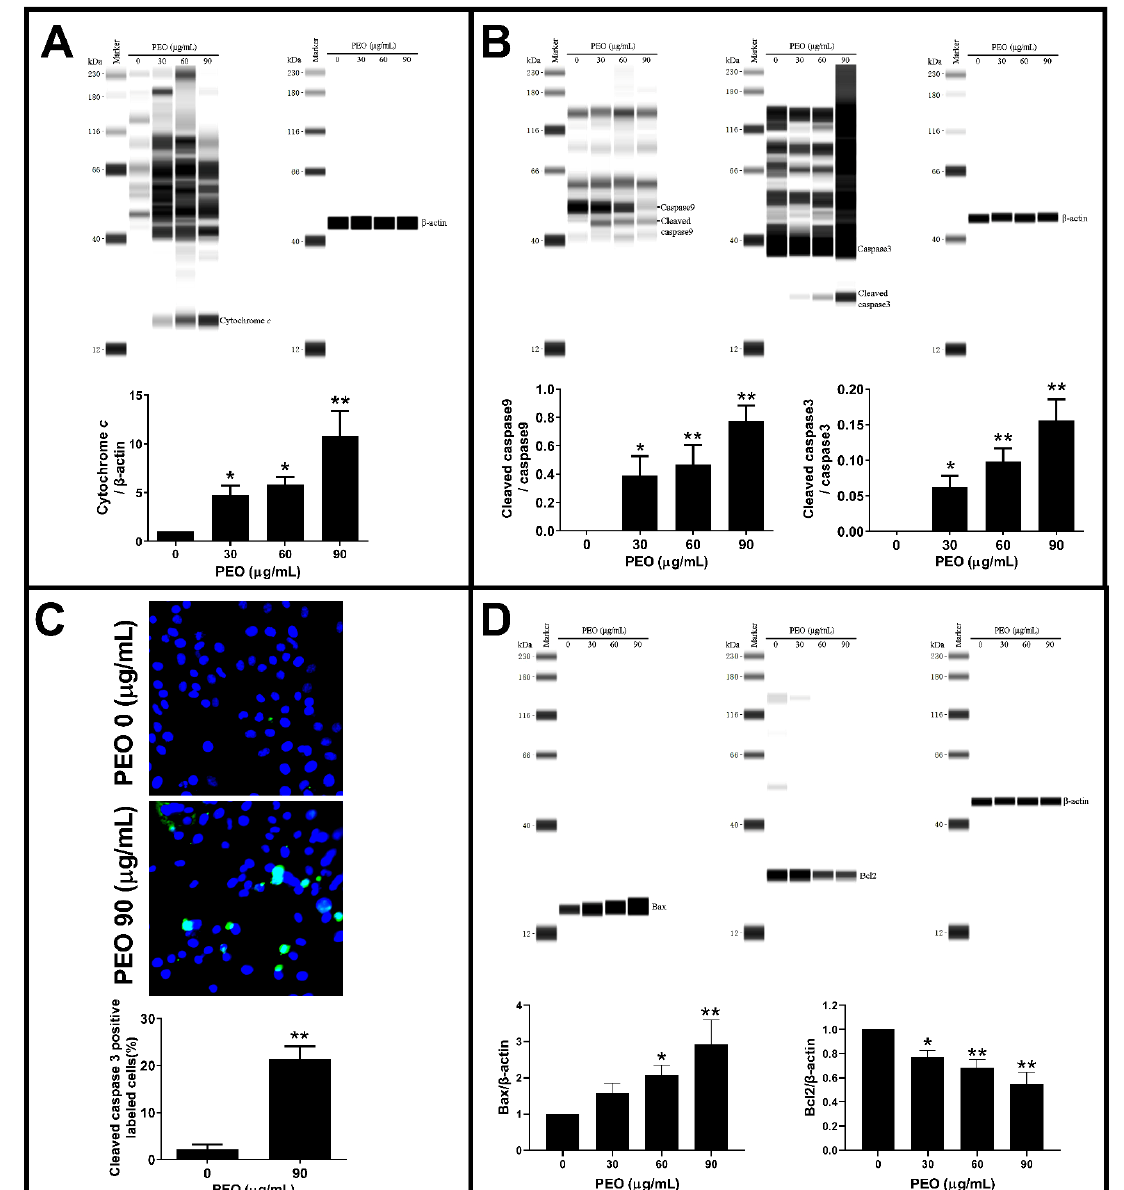
Figure 9. Effects of PEO on the expression of apoptosis-related proteins in A549 cells. A549 cells were treated with different concentrations of PEO for 9 h, cells were harvested, and the cytoplasmic protein was extracted with cell mitochondria isolation kit, then ( A ) the cytochrome c levels in cytoplasm were determined with β -actin as internal standard. Additionally, the whole cell lysates were prepared, and the protein levels of ( B ) cleaved caspase 9/caspase 9 and cleaved caspase 3/caspase 3 were detected with β -actin as internal standard. ( C ) For detection of cleaved caspase 3 in apoptotic cells, A549 cells were treated with 90 µg/mL PEO for 9 h, then cells were fixed, and permeabilized for immunocytochemistry with anti-cleaved caspase 3 primary antibody. After incubation with Alexa Fluor secondary antibody, cells were re-stained with DAPI to visualize the nucleus. The anticleaved caspase 3 positive labeled cells (green) were remarkably increased after PEO exposure. ( D ) A549 cells were treated with different concentrations of PEO for 9 h, the whole cell lysates were prepared, and the protein levels of Bax and Bcl2 were detected with β -actin as internal standard. The values represent mean ± standard deviation of three independent experiments. * p < 0.05, ** p < 0.01 compared with the control